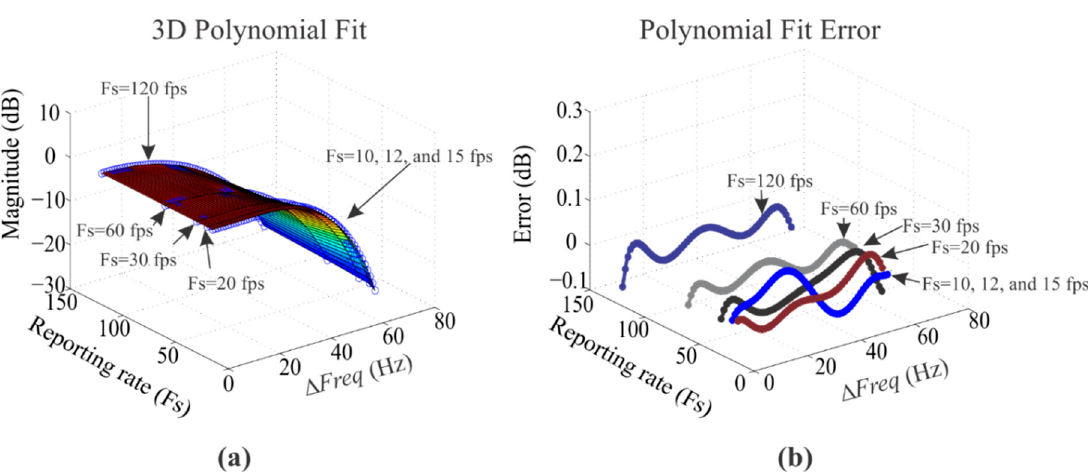
Figure 3. 3D fit results: ( a ) 3D surface and ( b ) Polynomial fit error. Mathematics 2020 , 8 , x FOR PEER REVIEW